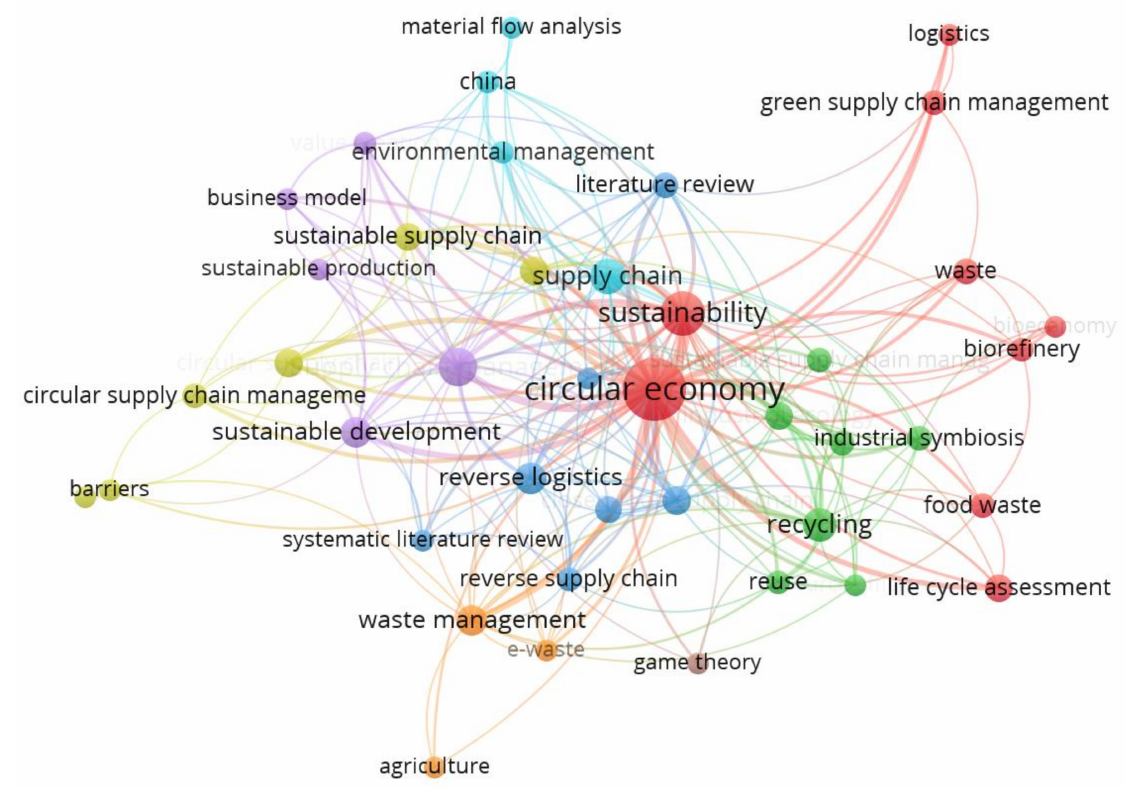
Figure 8. Co-occurrence of the most significant author keywords in the CSCM